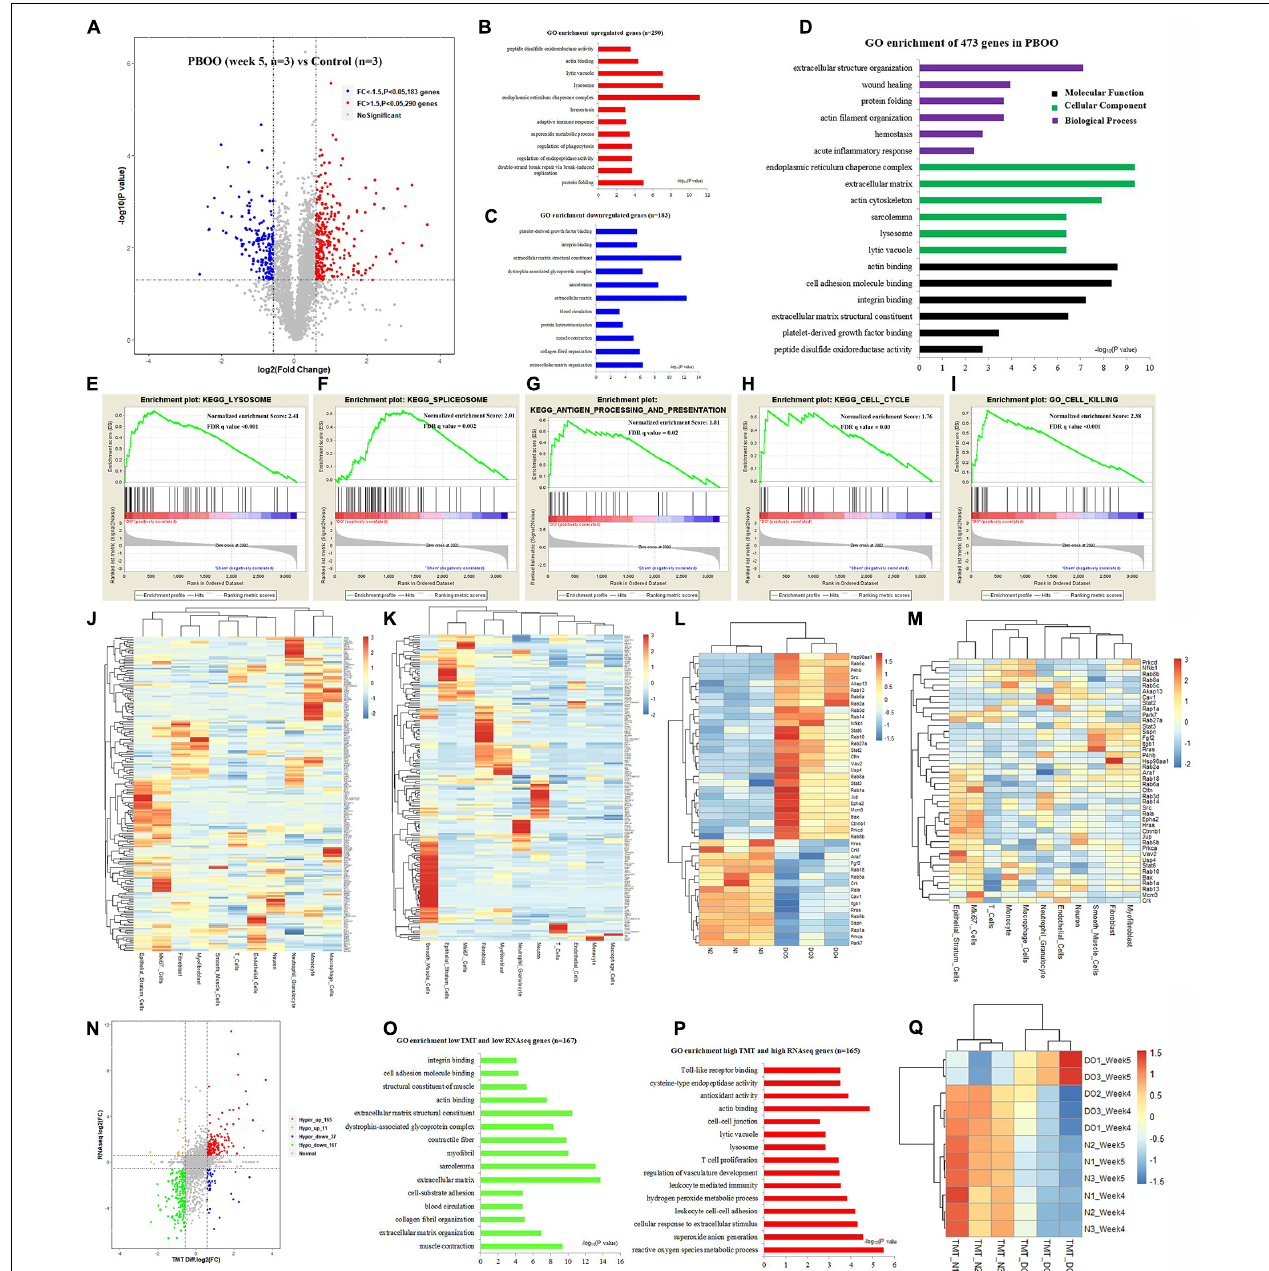
FIGURE 5 | TMT-labeling proteomic analysis comparing bladder tissues of week 5 PBOO and normal rat. Volcano plot (A) show 290 high (red color) and 183 low expression proteins (blue color) in week 5 PBOO rat bladder tissues ( n = 3) compared with normal ( n = 3). GO enrichment analysis of high expression proteins ( n = 290) in PBOO rat bladder tissue (B) . GO enrichment analysis of low expression proteins ( n = 183) in PBOO rat bladder tissue (C) . GO enrichment analysis of high and low expression proteins ( n = 473) in PBOO rat bladder tissue (D) . GSEA analysis show four major KEGG pathway changes in PBOO rat bladder tissues compared normal (E–I) . Heatmap plot show 290 high expression gene were distributed in different bladder cell (J) . Heatmap plot show 183 low expression gene were distributed in different bladder cell (K) . Picking up 76 high and low expressed growth factors (L) in PBOO rat bladder, and enrichment in different cell types in bladder tissues (M) . Data consistency between RNA-seq and TMT-labeling proteomic analysis (N) . GO enrichment analysis of 167 low expression genes and proteins in PBOO rat bladder tissue (O) . GO enrichment analysis of 165 high expression genes and proteins in PBOO rat bladder tissue (P) . Pearson correlation between RNA-seq and TMT-labeling proteomic analysis (Q)